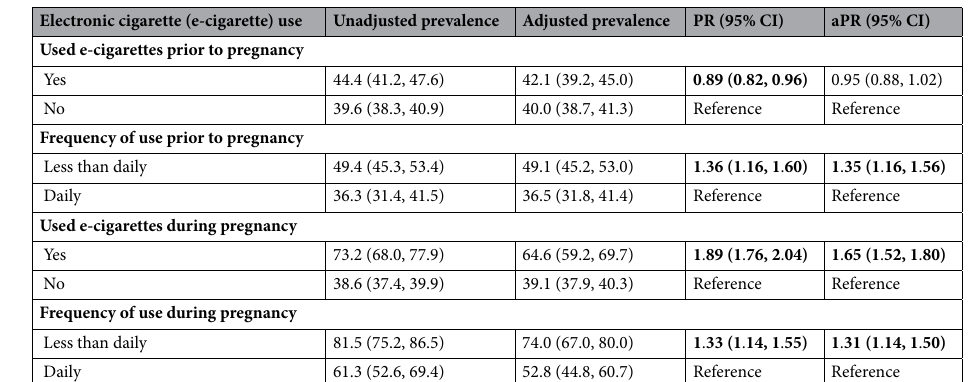
Table 1. Prevalence of combustible cigarette smoking by electronic cigarette use prior to and during pregnancy and US women (N = 16,022)—Pregnancy Risk Assessment Monitoring Survey, United States, 2016–2018. Bolded text indicates significant at p < 0.05. Adjusted by maternal age, race/ethnicity, and education, adequacy of prenatal care, multivitamin use, rurality of residence, WIC access, and pregnancy intention. PRAMS sites included in this analysis are: Alaska (2016–2018), Alabama (2017), Arkansas (2016), Colorado (2016–2018), Connecticut (2016–2018), Delaware (2016–2018), Georgia (2017–2018),